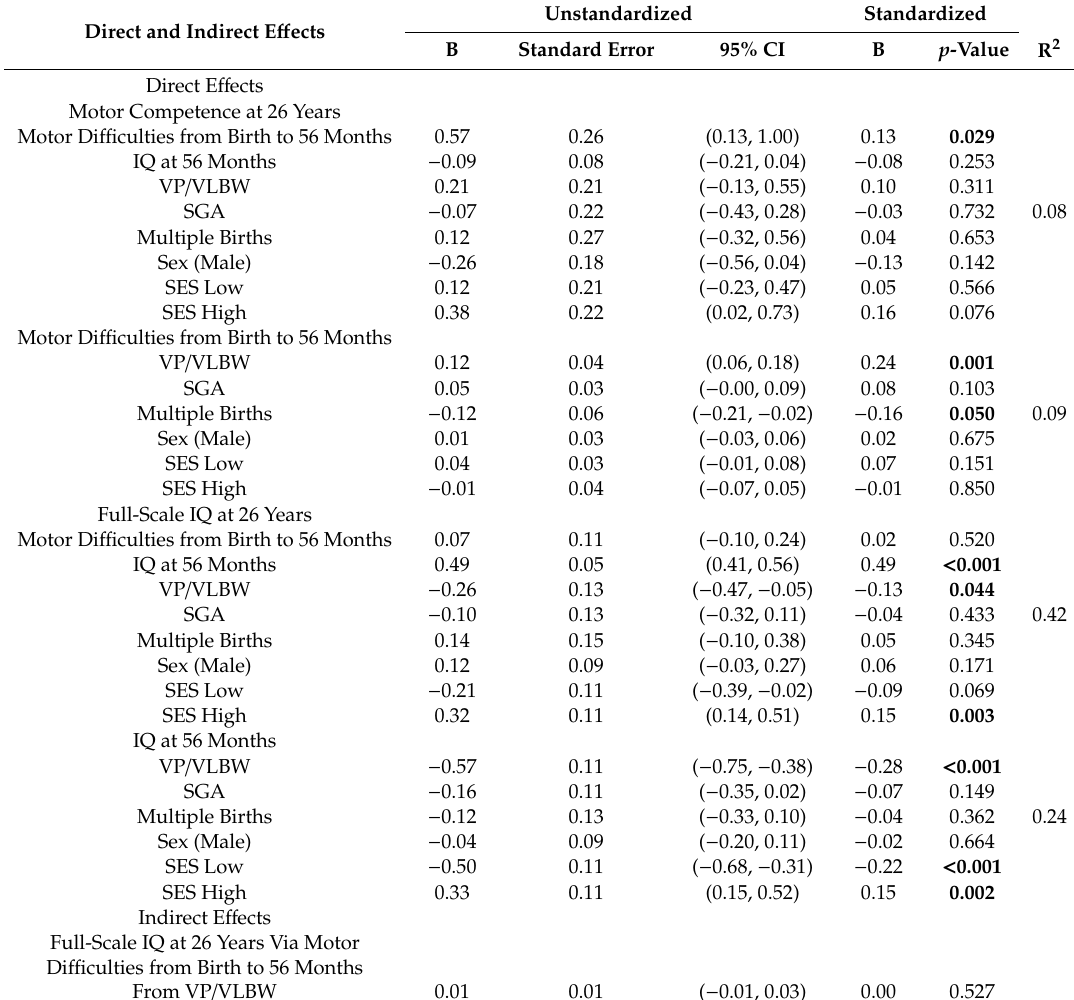
Table 3. Regression coe ffi cients using structural equation modelling (excluding participants with neurological impairment, Model